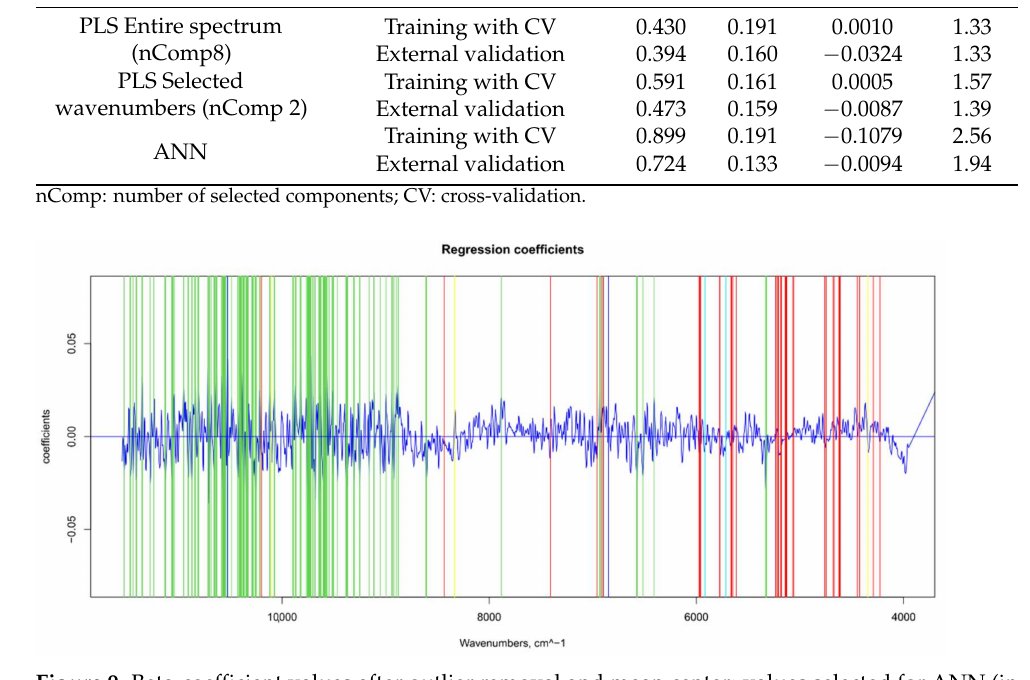
Figure 9. Beta-coefficient values after outlier removal and mean center: values selected for ANN (in green), main NIR peaks for water (in blue), sugar and water (in light blue), sugar and organic acids (in yellow), and pectins (in